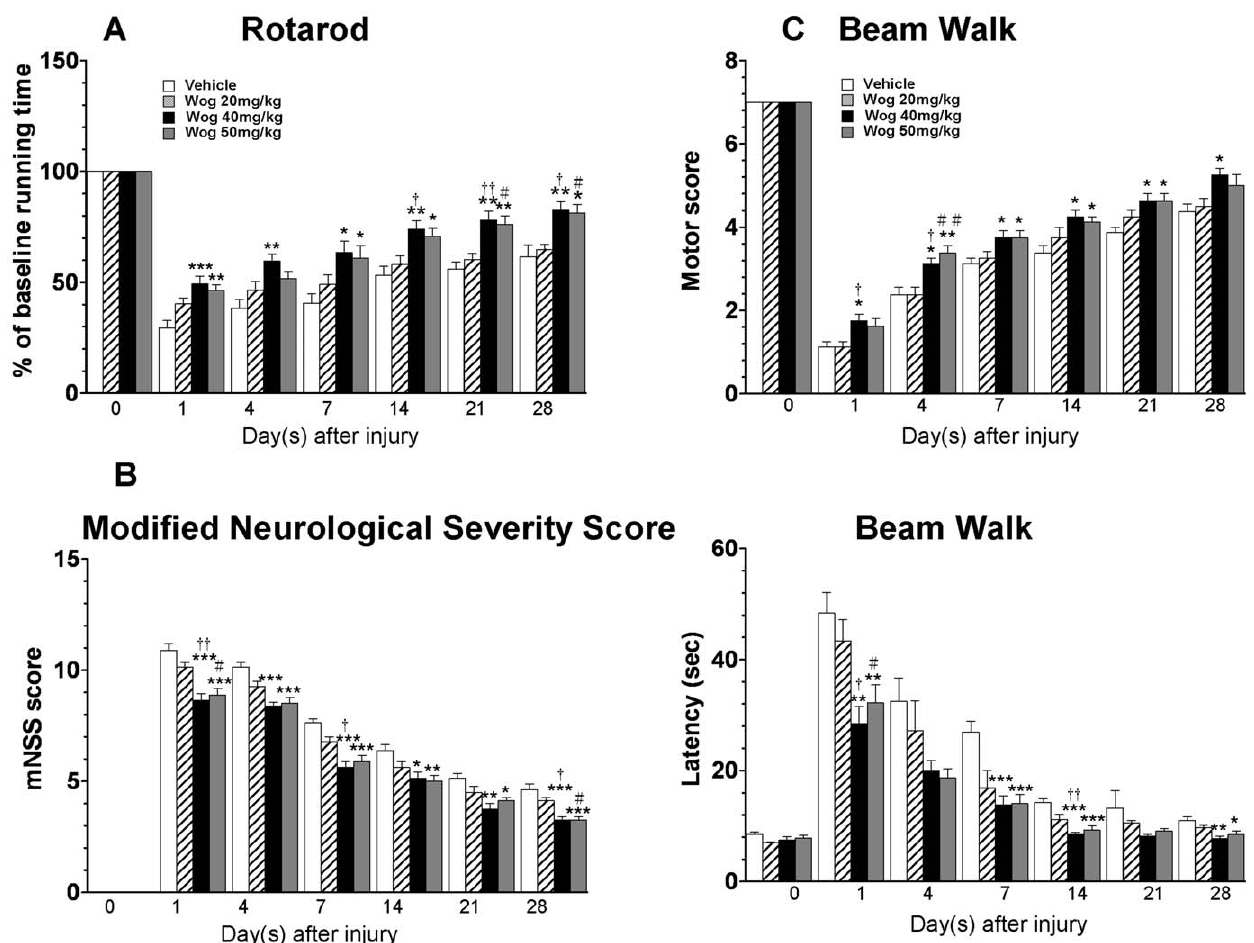
Figure 1. Effects of 3 different doses of wogonin on functional outcomes in contusion-injured mice. ( A ) Compared to the vehicle treatment, 20 mg ? kg 2 1 wogonin treatment did not significantly alter rotarod performance. On days 1–28, 40 mg ? kg 2 1 wogonin-treated mice performed significantly better than the vehicle-treated mice. On days 1, 7, 14, 21, and 28, the 50 mg ? kg 2 1 wogonin-treated mice had better rotarod performance than the vehicle-treated mice. No significant differences were observed between the 40 mg ? kg 2 1 and 50 mg ? kg 2 1 wogonin treatment groups at any time point. ( B ) No difference in modified Neurological Severity Score (mNSS) was detected between the 20 mg ? kg 2 1 wogonin and vehicle treatment groups. On days 1–28, the mNSSs were significantly lower in the 40 mg ? kg 2 1 and 50 mg ? kg 2 1 dose groups than in the vehicle- treated group. No significant differences were observed between the 40 mg ? kg 2 1 and 50 mg ? kg 2 1 treatment groups. ( C ) During the beam walk test, no significant differences were observed between the 20 mg ? kg 2 1 wogonin-treated and vehicle-treated groups. Significant differences were observed in the hindlimb motor scores between the 40 mg ? kg 2 1 wogonin-treated and vehicle-treated groups on post-injury test days 1–28 and between the 50 mg ? kg 2 1 dose group and vehicle group on days 4, 7, 14, and 21. Differences in hindlimb motor scores between the 40 mg ? kg 2 1 and 50 mg ? kg 2 1 groups were not significant. Beam walk latencies were significantly shorter for both the 40 mg ? kg 2 1 and 50 mg ? kg 2 1 groups than for the vehicle group, on days 1, 7, 14, and 28; however, no significant difference was observed between the 2 wogonin-treated groups. Values are presented as mean 6 SEM; * P , 0.05, ** P , 0.01, *** P , 0.001 versus vehicle-treated injured mice. { P , 0.05, {{ P , 0.01: 20 mg ? kg 2 1 wogonin-treated mice versus the 40 mg ? kg 2 1 wogonin-treated mice. # P , 0.05: 20 mg ? kg 2 1 wogonin-treated mice versus the 50 mg ? kg 2 1 wogonin-treated mice (n=8 mice/group at each time point). doi:10.1371/journal.pone.0030294.g001 term effects were evaluated at day 28 post-injury by which time the enlargement and brain water content 1 day post-TBI. BBB cortical contusion volume in the vehicle-treated TBI group was measured to be 12.0 6 0.9 mm 3 (Fig. 2A). Treatment with wogonin resulted in reduction of lesion size by 24.2% to 9.1 6 0.8 mm 3 , which was significantly smaller than the vehicle-treated group ( P , 0.05; Fig. 2A). Disruption of the blood-brain barrier (BBB) and brain edema can cause brain swelling and increased intracranial pressure following TBI, leading to secondary injury and cell death [20]. To assess whether the reduction in neurological deficits and brain injury after wogonin treatment correlated with reduced BBB reduce brain edema at day 1, when brain edema reached the disruption and brain edema, we next examined hemispheric